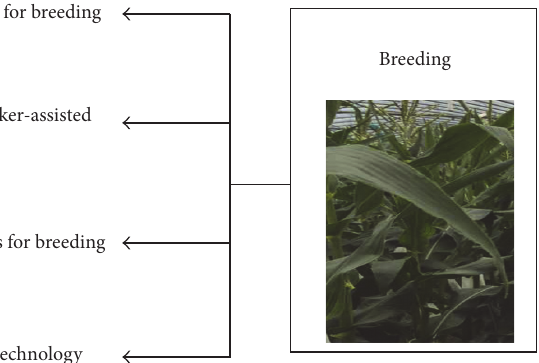
Figure 1: Advances in this special